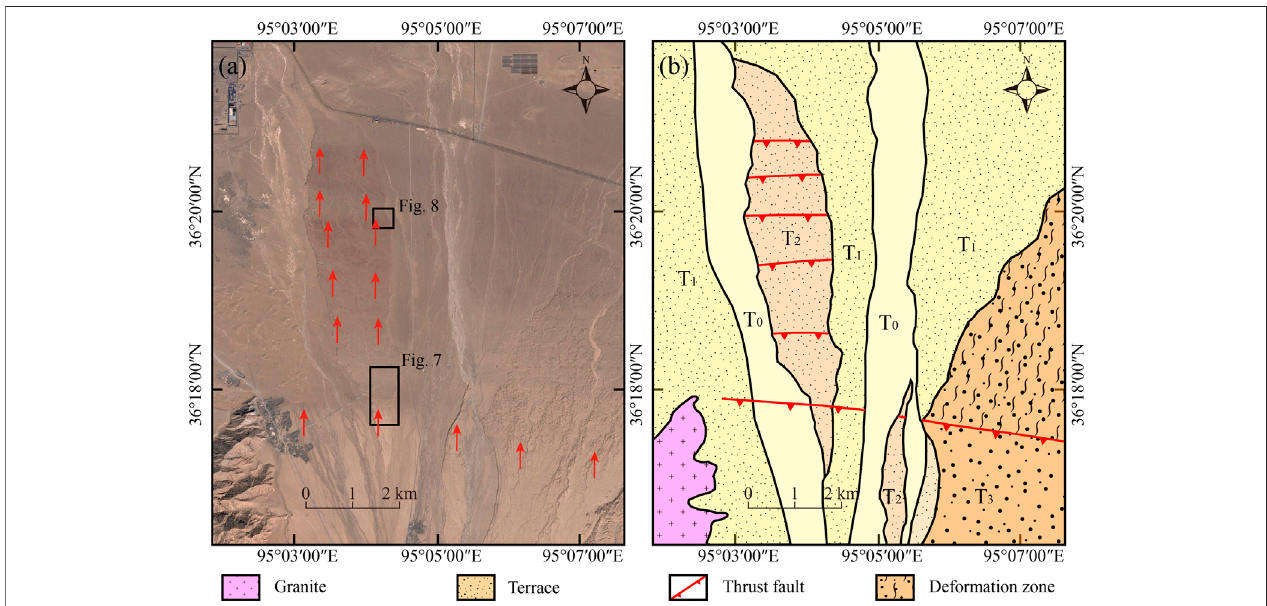
FIGURE 6 | (A) Image from Google Earth image at the Hongliugou site. Red arrows indicate the active fault trace. The black boxes indicate the locations of the following fi gures. (B) Interpretation of the Terraces. Red bold lines represent the active fault traces.